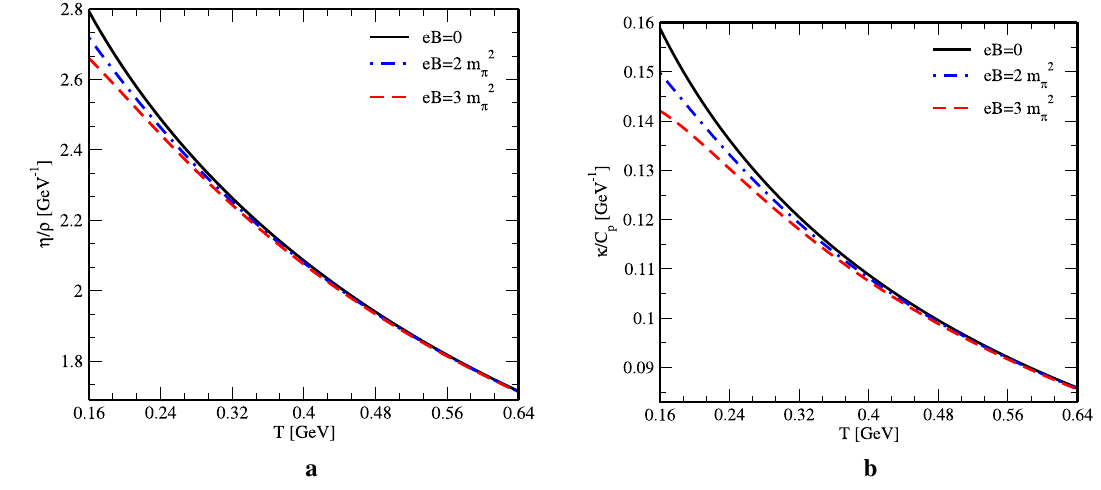
Fig. 5 Variations of ( a ) η/ρ and ( b ) κ/ C p with temperature at different values of magnetic